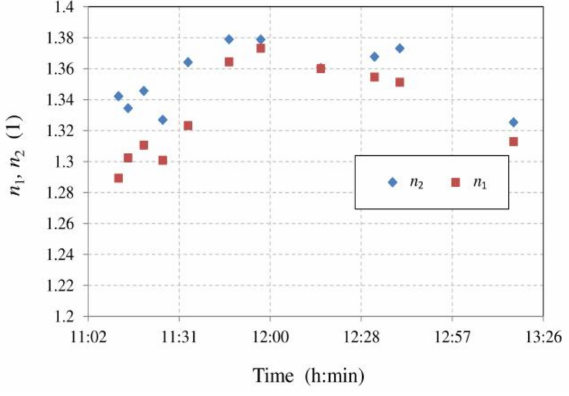
Figure 13. Values of the polytropic exponents n 1 and n 2 .